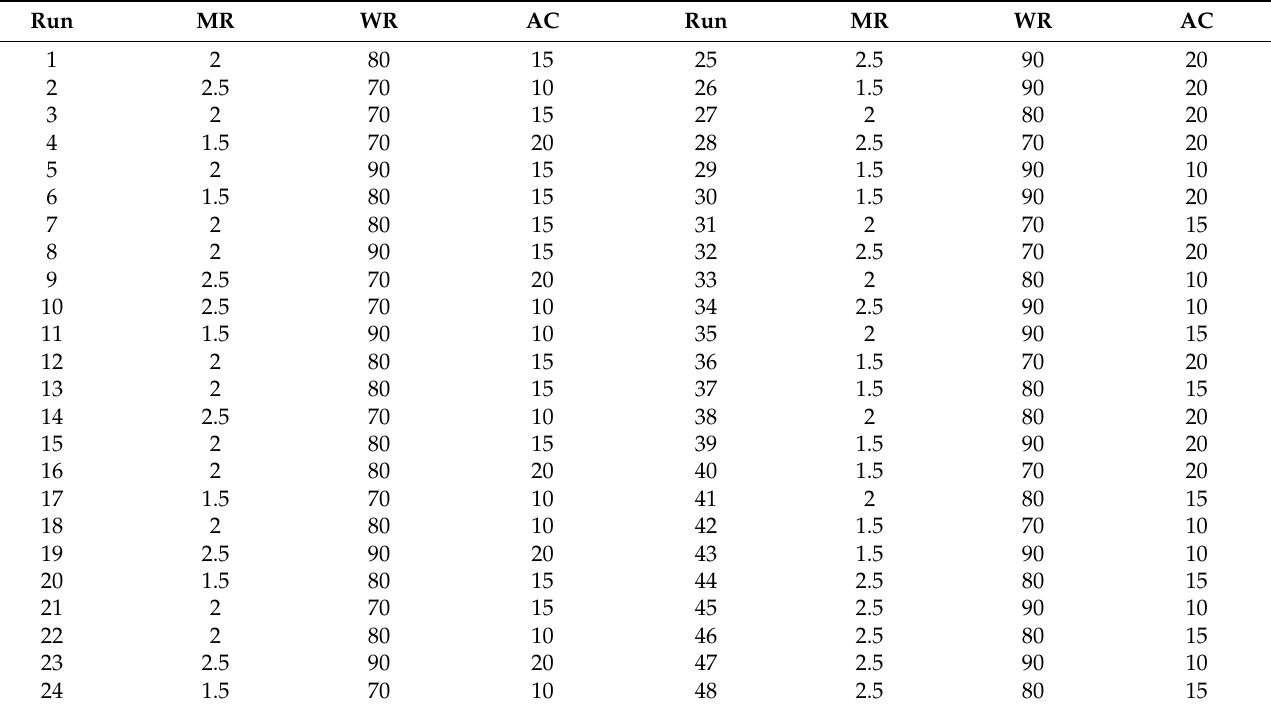
Table 1. Experimental